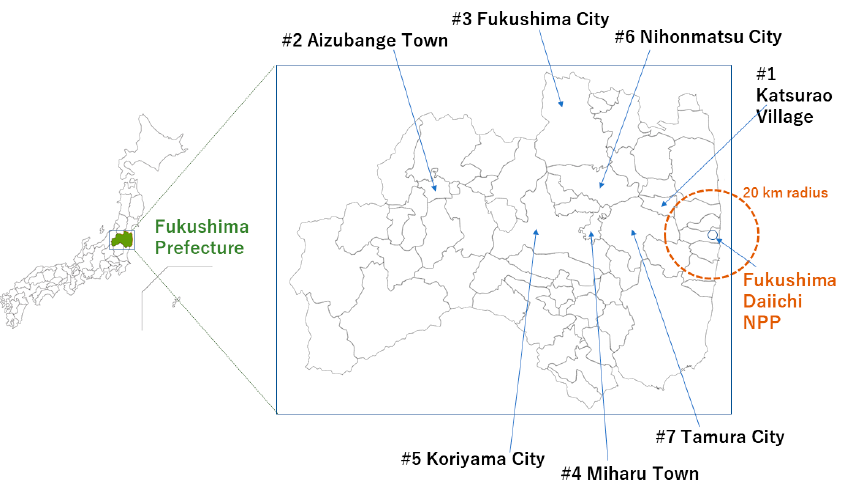
Figure 1. Location of municipalities during the evacuation process from Katsurao Village. The geographical relationships between the Fukushima Daiichi Nuclear Power Plant and Tamura City, Miharu Town, Koriyama City, Nihonmatsu City, Fukushima City, and Aizubange Town are shown.